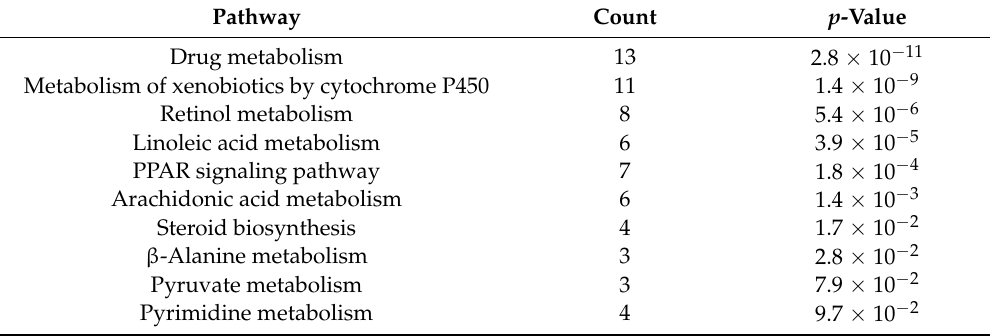
Table 2. The most significant canonical pathways by analyzing the differentially expressed proteins.